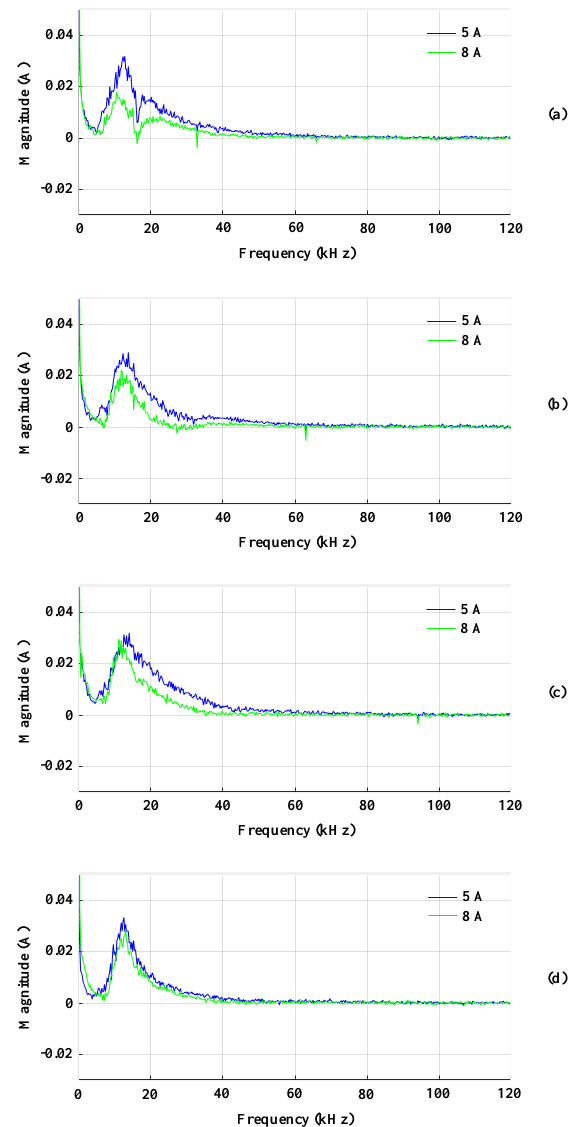
Figure 7. FFT differences after and before arc generation based on the current magnitude and average switching frequency in I arc 2 : ( a ) 5 kHz, ( b ) 10 kHz, ( c ) 15 kHz, and ( d ) 20 kHz.